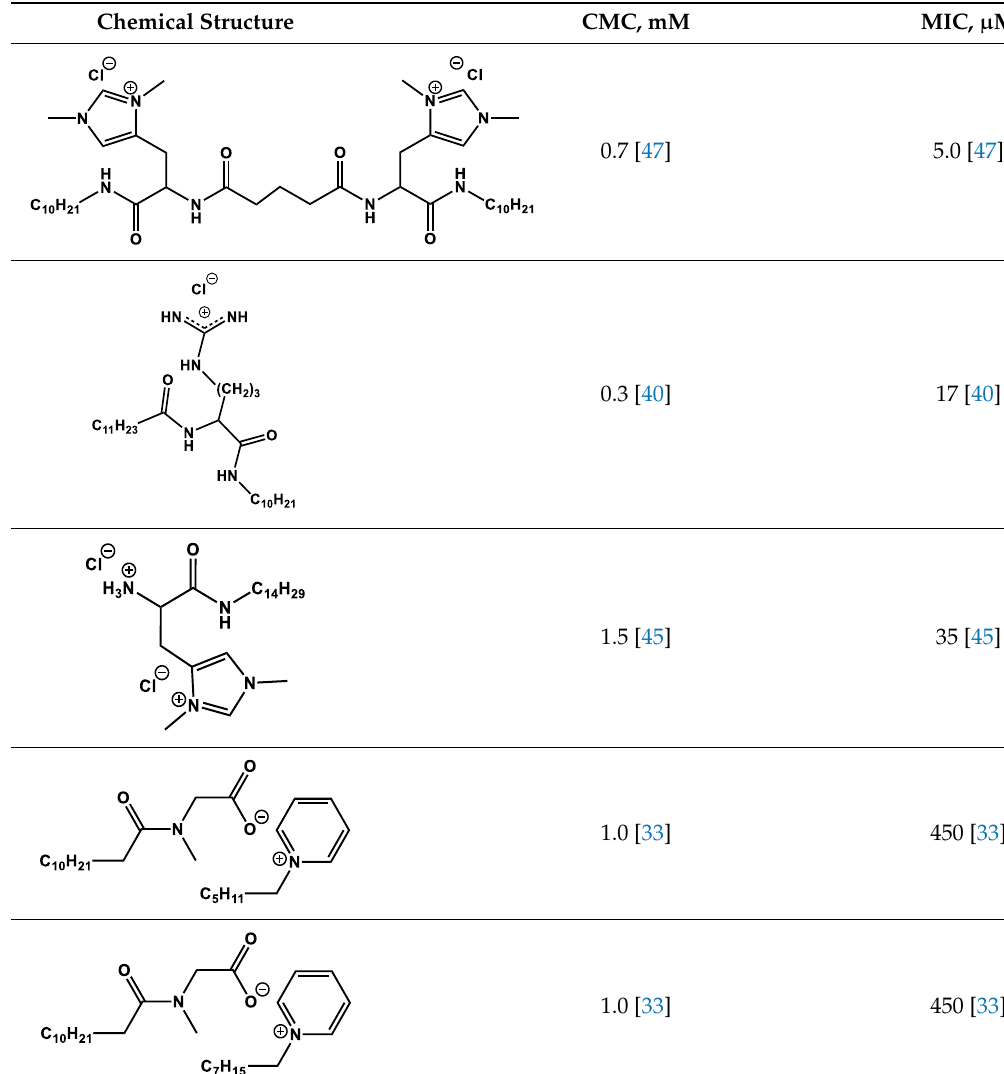
Table1. CMCvaluesandminimalinhibitoryconcentrations(MIC, µ M)against Staphylococcusepidermidis Table 1. CMC values and minimal inhibitory concentrations (MIC, μM) against Staphylococcus strains for several amino acid-based surfactants. epidermidis strains for several amino acid-based